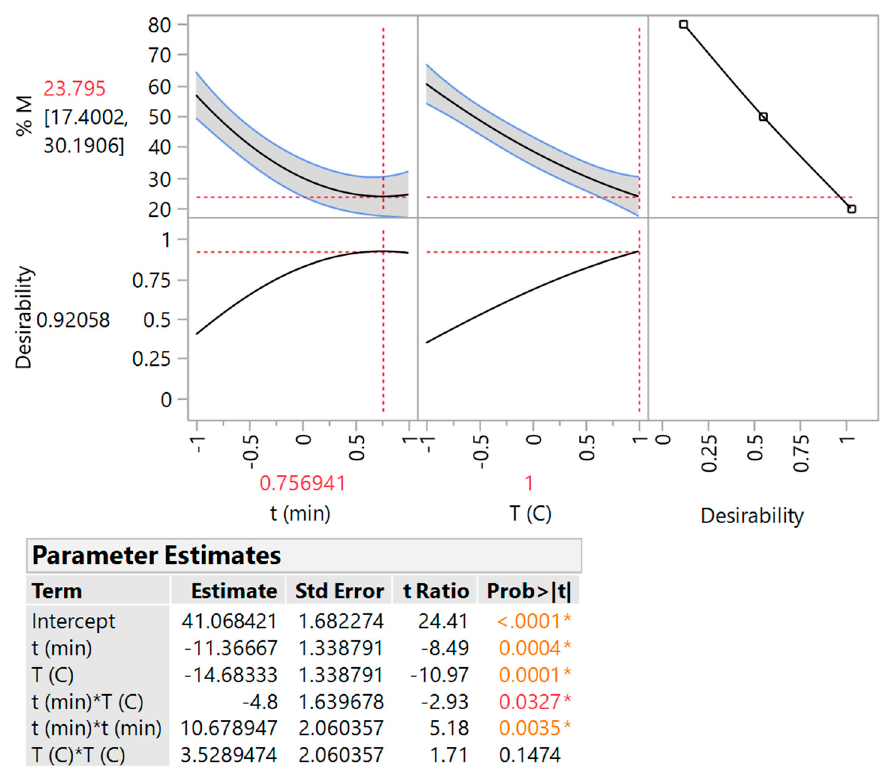
Figure 1. Desirability function and response surface statistics associated with PP drying modelling. Asterisk denotes statistically significant terms.